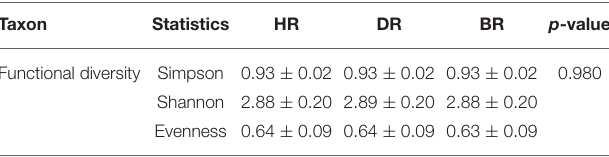
TABLE 2 | The functional group diversity and evenness assessment of the rhizobiome at level 1 of the SEED subsystem of the soil samples. Taxon Statistics